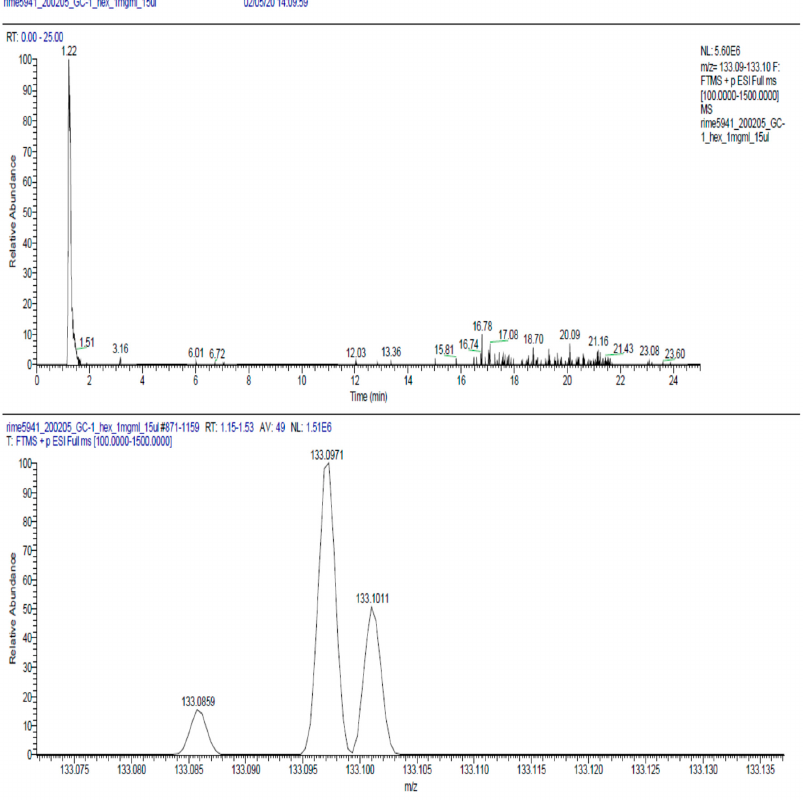
Figure A3. UPLC-MS analysis of the n -hexane extract of G. cambogia indicating the presence of ornithine.